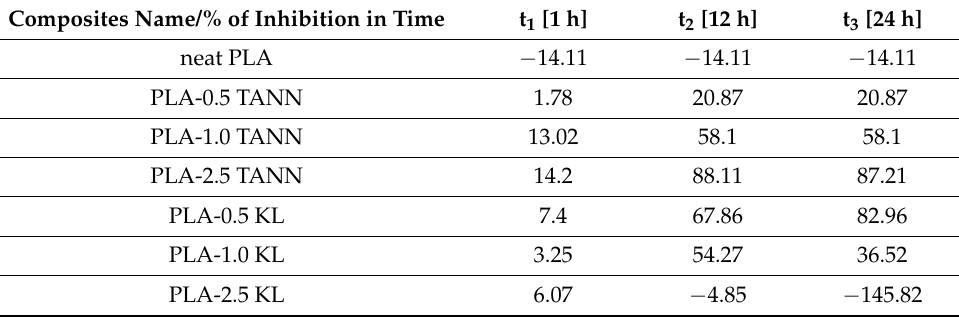
Table 3. Antibacterial assay of Neat PLA, PLA-KL, and PLA-TANN composites. Composites Name/% of Inhibition in